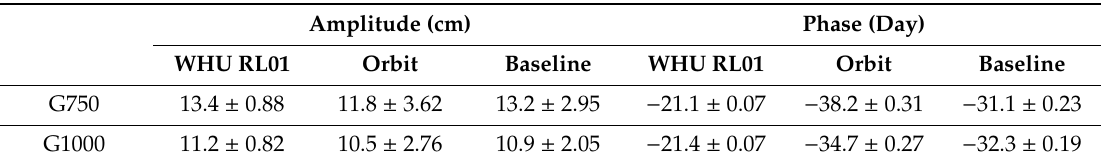
Table 5. Annual amplitudes (cm) and phases (day) and the associated formal errors of mass anomalies over the Amazon river basin derived from di ff erent